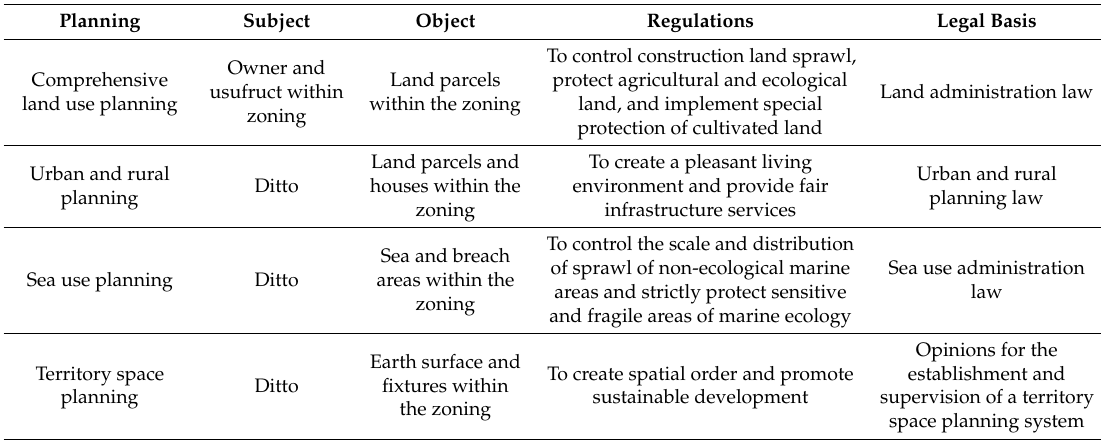
Table A4. Structure of public rights of natural resource